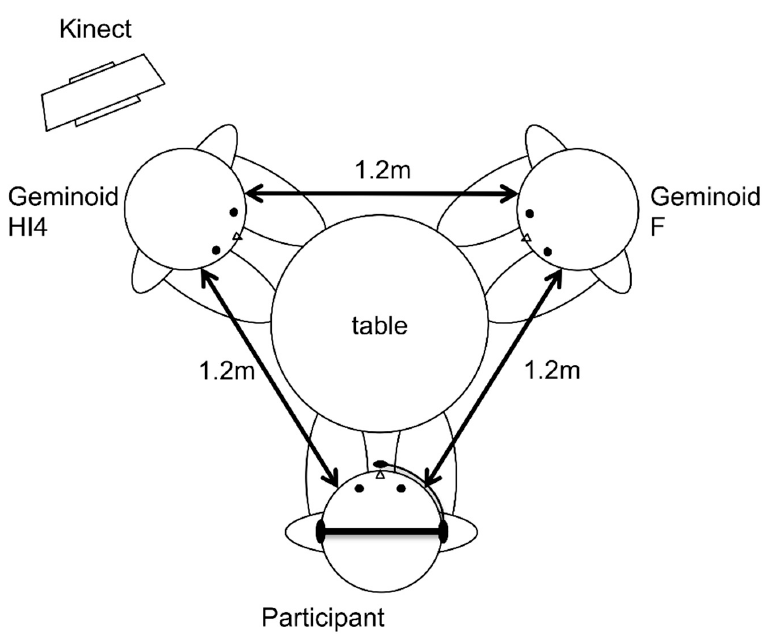
Figure 3. The environment of the experiment.